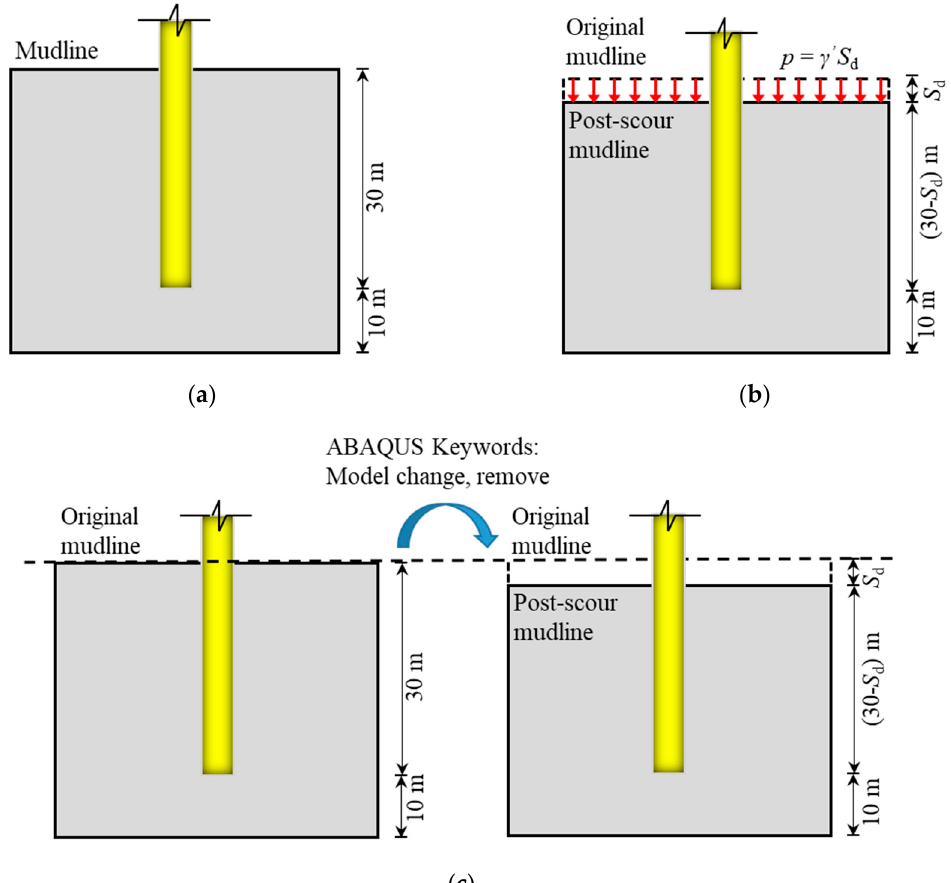
Figure 5. Schematic diagram of numerical modelling procedures of: ( a ) no scour; ( b ) scour ignoring the stress history effect; ( c ) scour considering stress history effect. Note: S d denotes scour depth; γ ’ denotes soil effective weight.